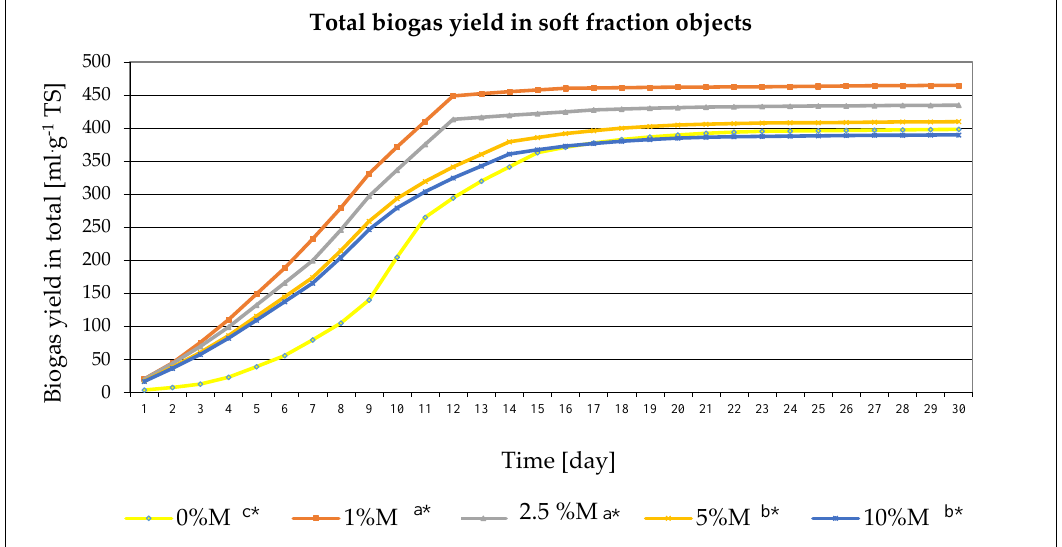
Figure 1. Total biogas yield in soft fraction objects. *Different letters mean statistically significant differences at the significance level p = 0.05.